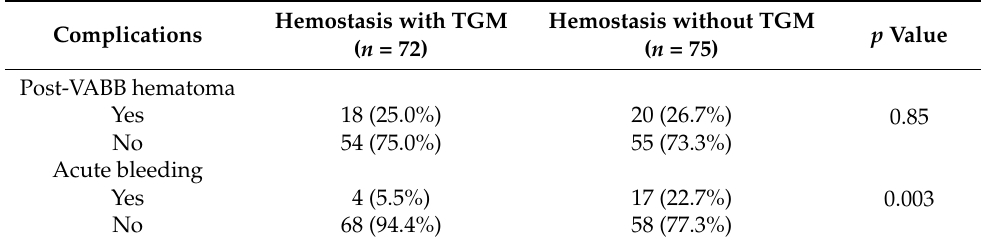
Figure 2. Patient with acute bleeding in Day 1. Table 2. Hematoma and acute bleeding.